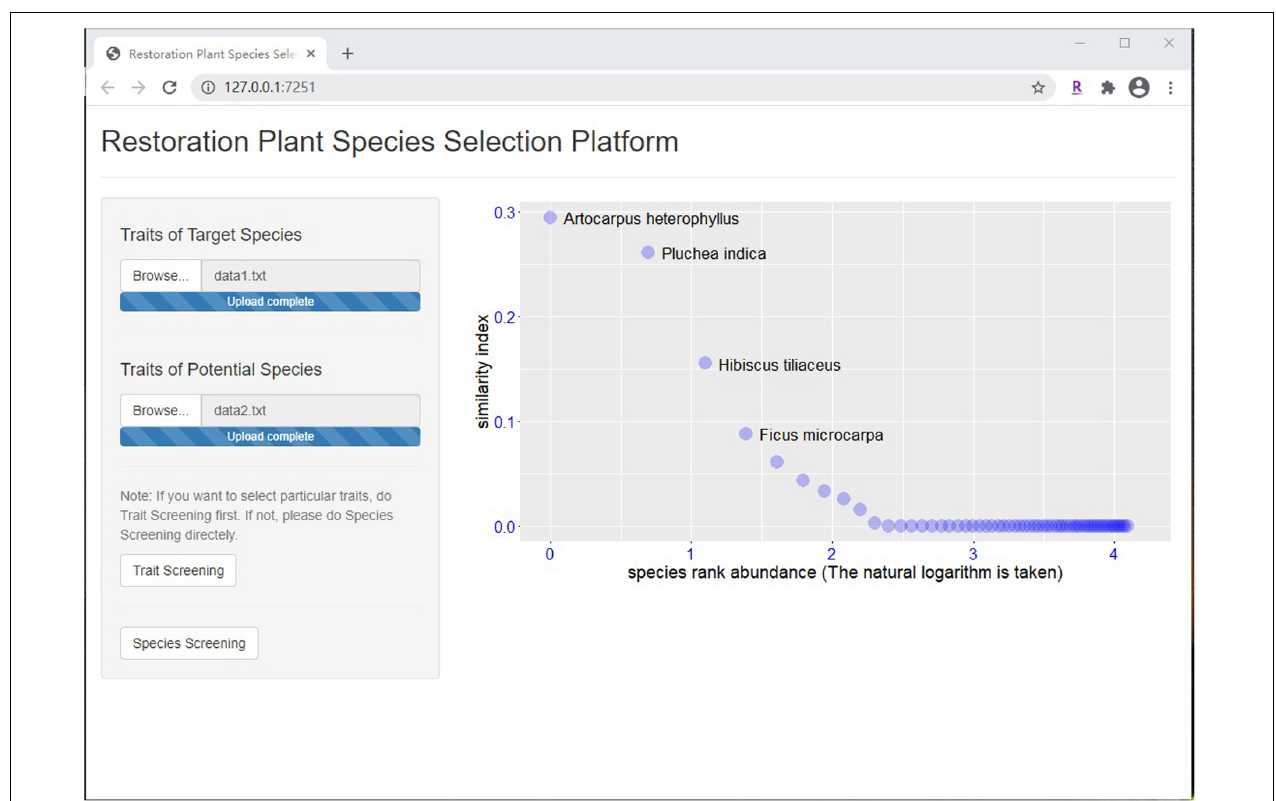
FIGURE 1 | The Graphic User Interface of the RPSS